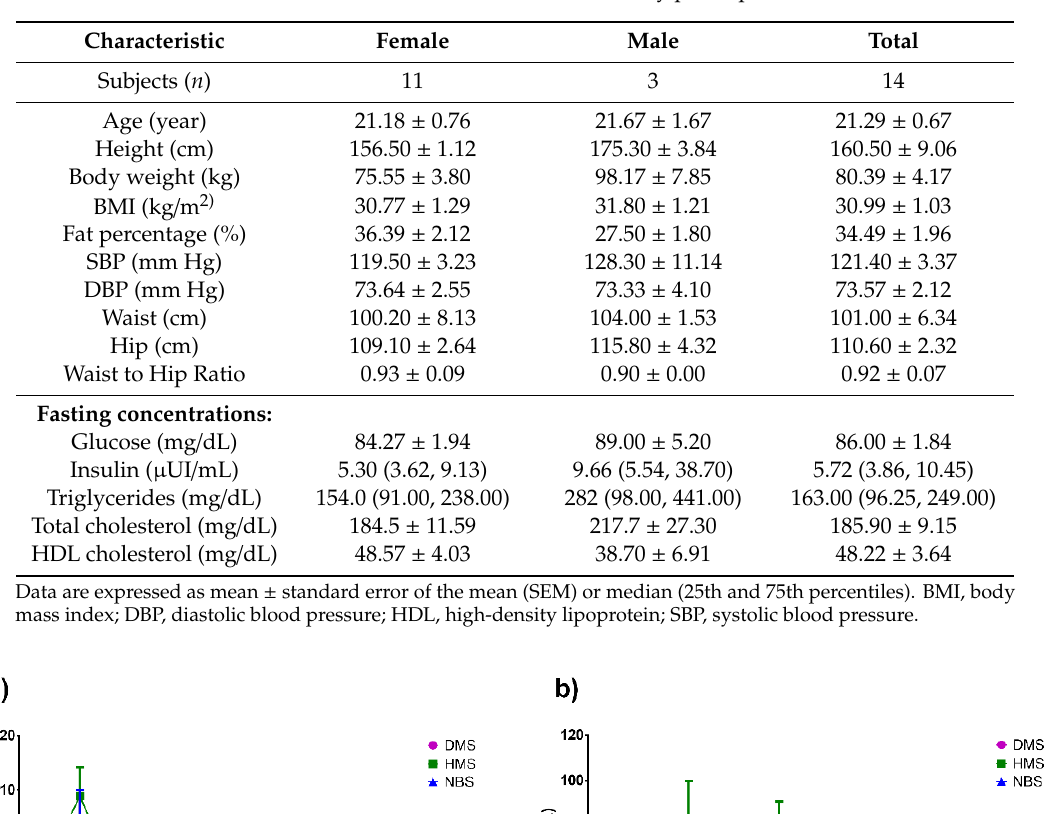
Table 1. Baseline characteristics of the study participants.